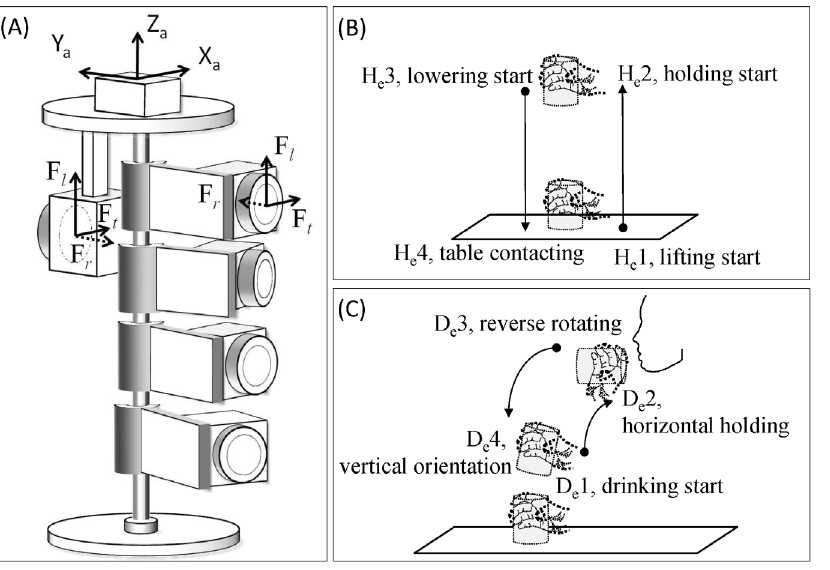
Figure 1. The cylindrical simulator and functional tasks. (A) Diagram of the cylindrical simulator, showing five force/torque transducers, the accelerometer and their local coordinate systems. Based on the obtained acceleration data, thus four movement events in the (B) holding and (C) drinking tasks were determined.